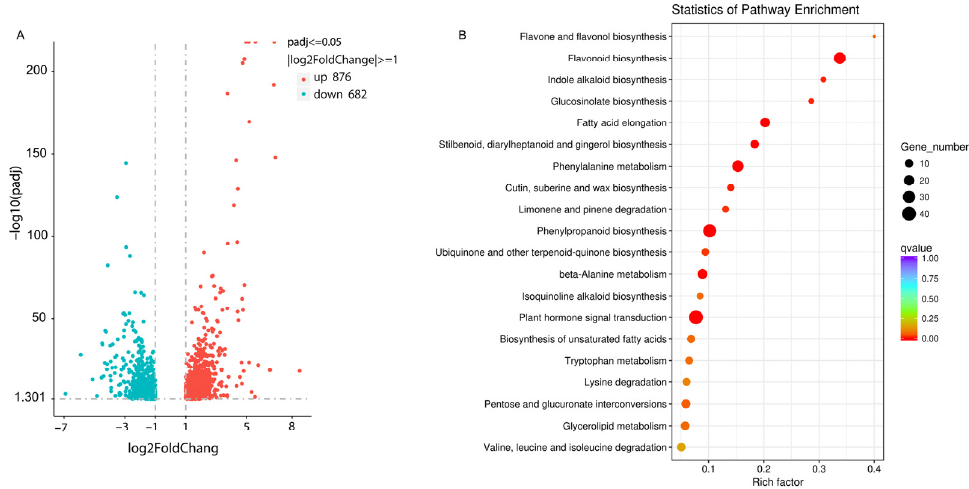
Figure 2. Volcano plot and KEGG pathway enrichment of DEGs. ( A ) Volcano plot and ( B ) KEGG